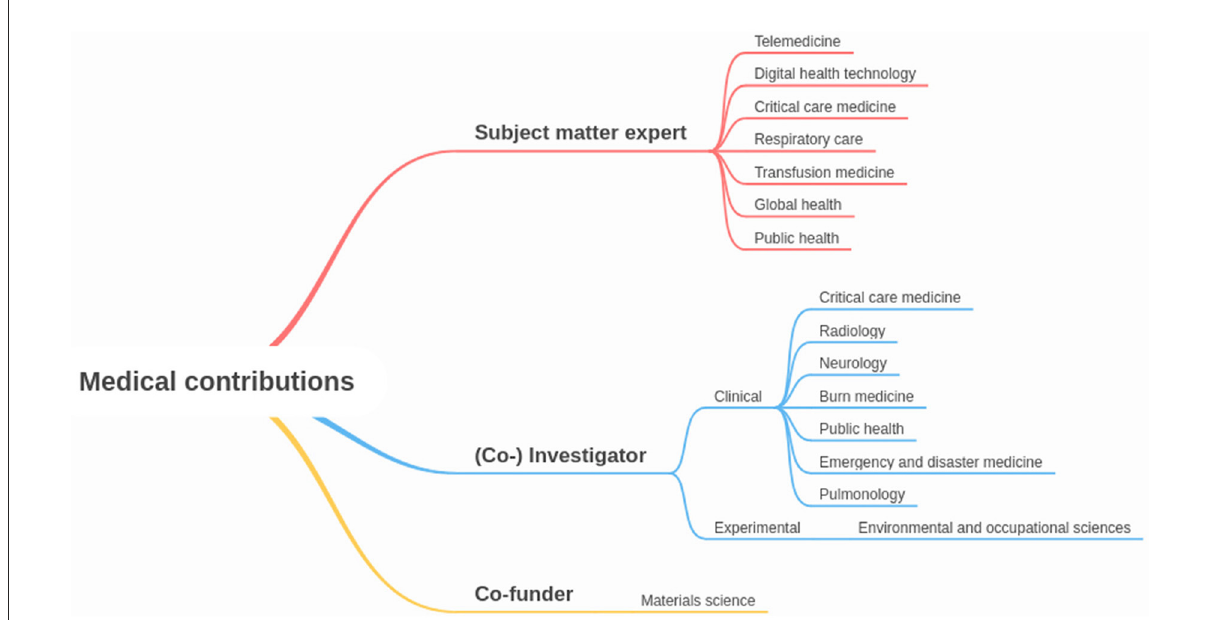
FIGURE2 Mindmap of medical contributions with the participation of military medical personnel or institutions by role and specialty area